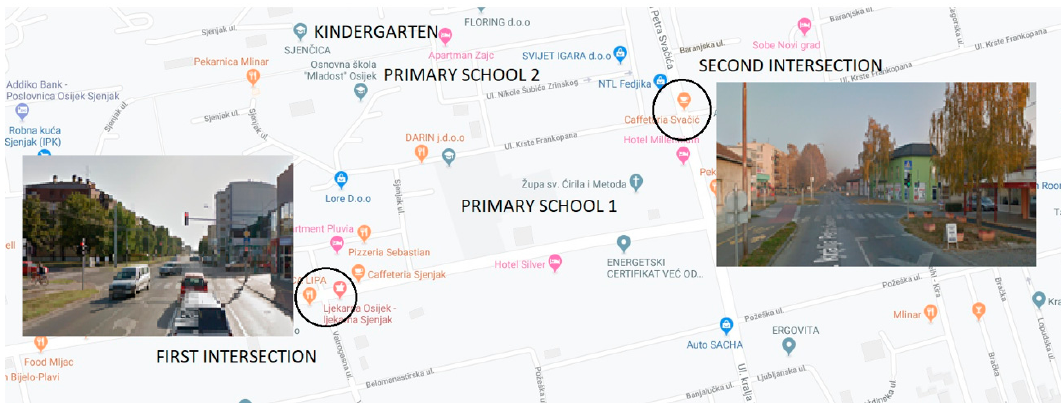
Figure 6. Observed traffic network segment ( Source: Author according to [33]).